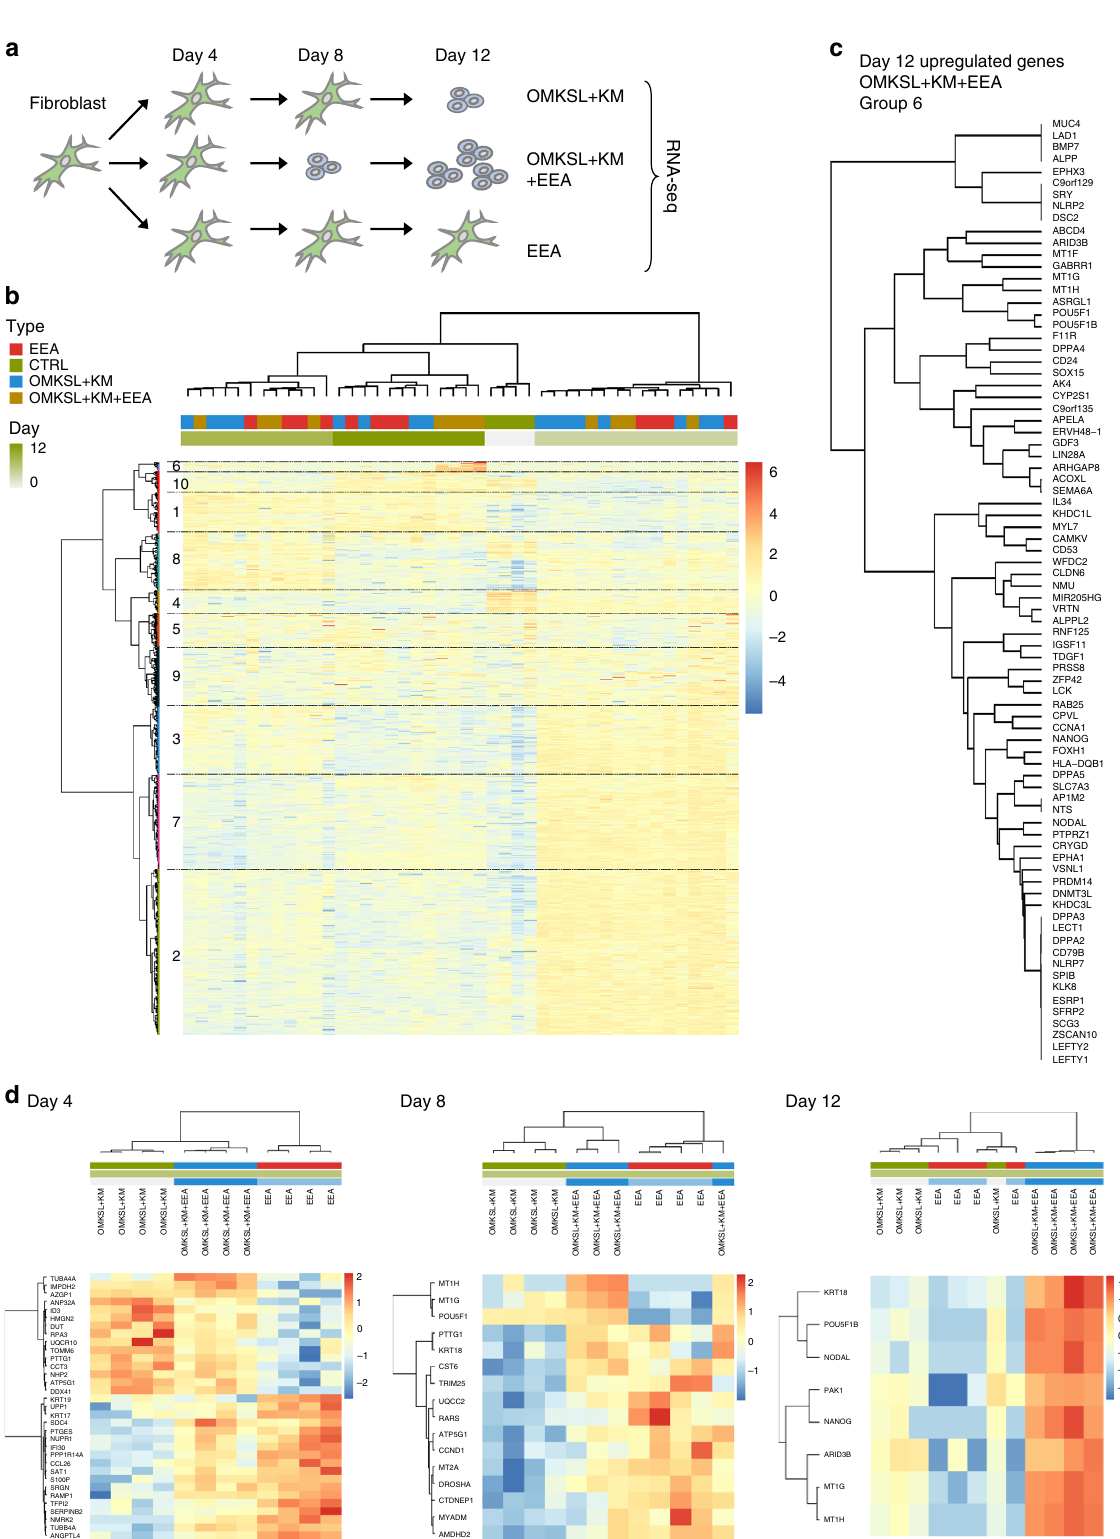
Fig. 4 Transcriptional analysis of reprogramming cell populations. a Schematic representation of skin fi broblast reprograming with dCas9VP192 for RNA sequencing samples. b Clustering of all reprogramming samples based on expression of 4972 signi fi cantly fl uctuated genes. Group 6 represents genes upregulated speci fi cally by EEA-guides at day 12. c Upregulated genes at day 12 of reprogramming in OMKSL + KM + EEA targeted cells (Group 6). d Clustering of samples within day 4, 8, and 12 time points based on differentially regulated